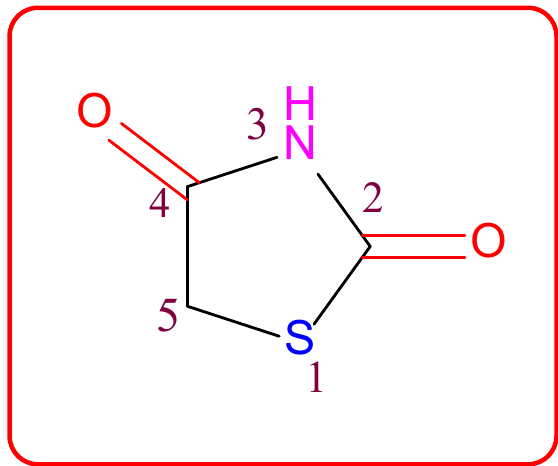
Figure 1. Structure of the thiazolidine-2,4-dione scaffold.